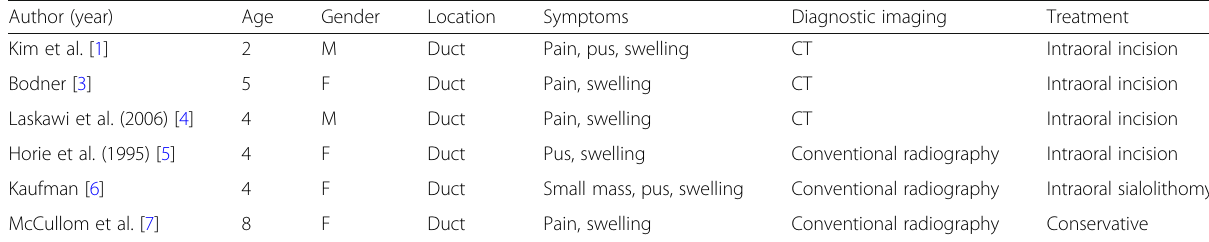
Table 1 Summary of published case reports on paediatric parotid sialolithiasis, the characteristics, presenting symptoms, diagnostic imaging and